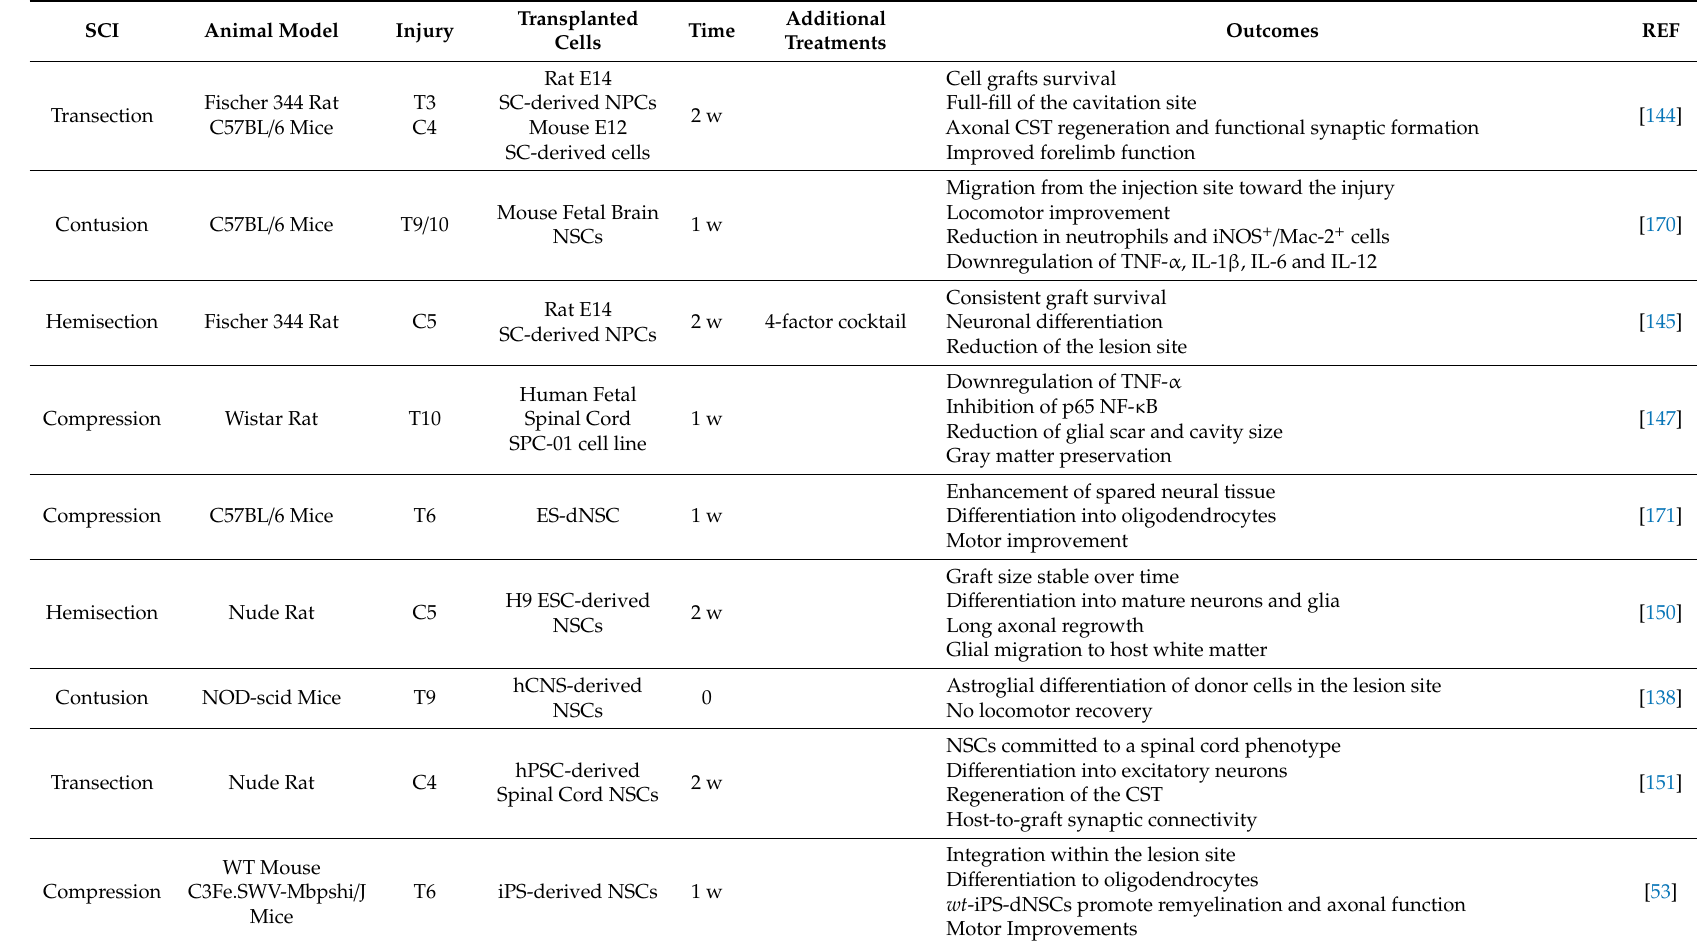
Table 2. Preclinical studies using neural stem cells transplantation to target spinal cord injury